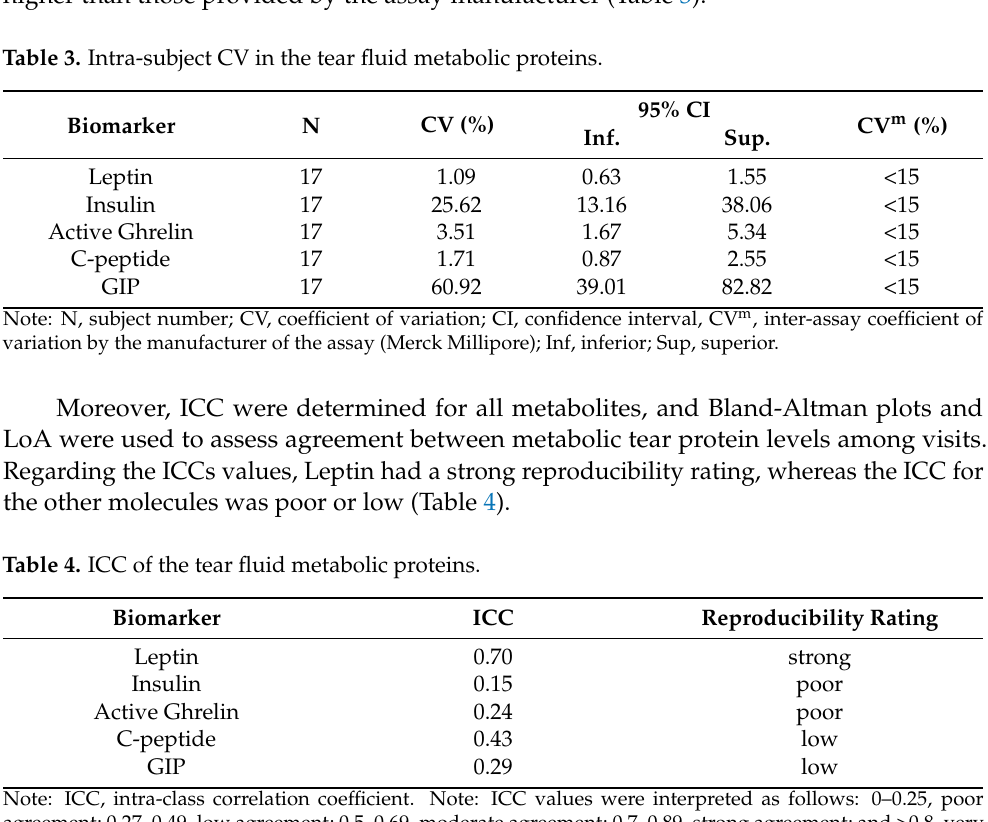
Table 3. Intra ‐ subject CV in the tear fluid metabolic proteins. Table 3. Intra-subject CV in the tear fluid metabolic proteins. Biomarker Biomarker Insulin